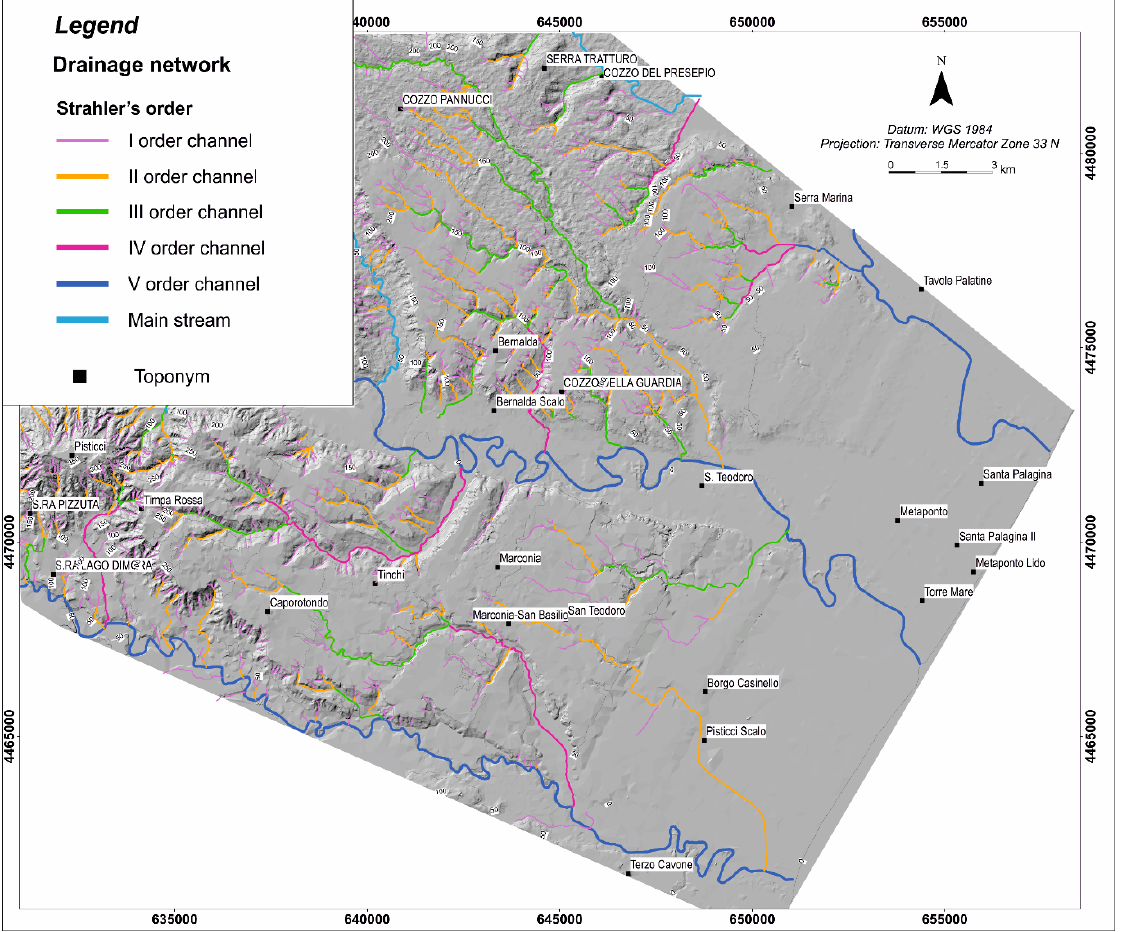
Figure 4. Drainage network of the study area. Channels are portrayed on a hillshade deriving by the 5 m DEM.